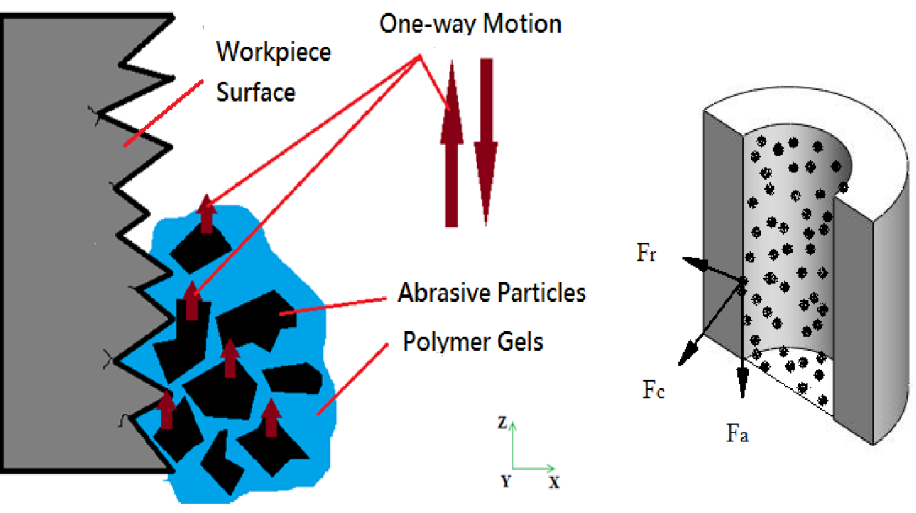
Figure 1. Loose abrasive-based machining process [26]. Figure 2 below signifies the various categories and sub-categories of the loose abrasive-based machining process.